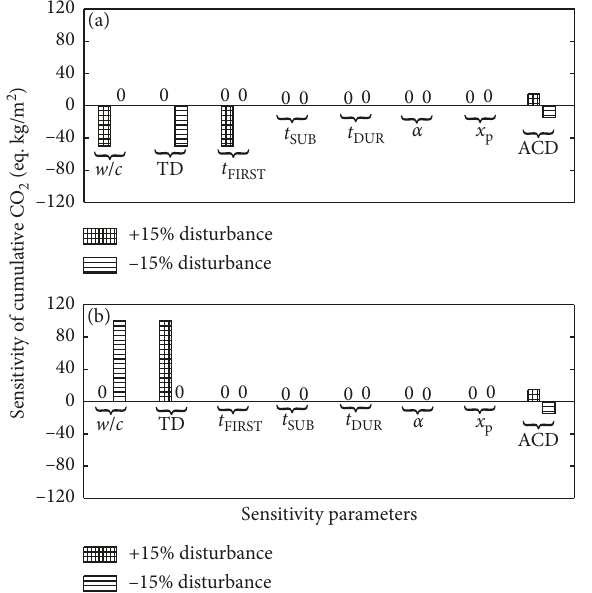
Figure 11: Sensitivity of cumulative CO with SL1 and